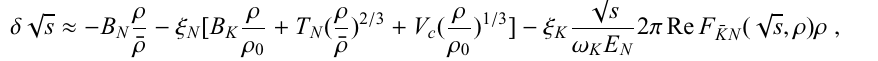
discussion below are relevant to K − atomic and nuclear states. The attraction as well as the imaginary- part absorptivity get moderately weaker for ρ ≥ 0 . 5 ρ 0 , as demonstrated by comparing on the left panel the solid curves ( ρ = ρ 0 ) with the dashed curves ( ρ = 0 . 5 ρ 0 ). This implies that K − bound states